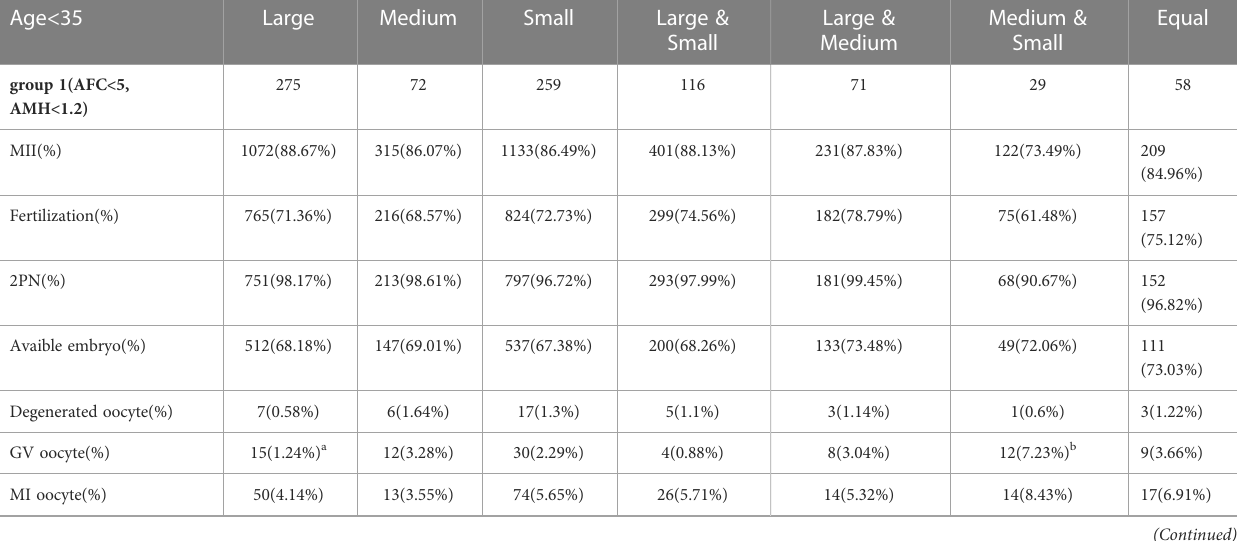
TABLE 2 Strati fi ed analysis of oocyte and embryology quality in groups of follicles size after grouping by AFC and AMH in young patients.